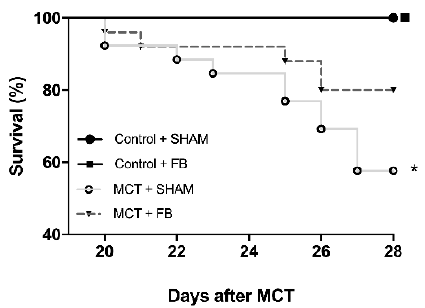
Figure 7. Effect of xanthohumol-fortified beer (FB) on animal survival. The absence of survival curve in Control + SHAM means that all the animals survived until the end of the protocol; the curve is superimposed with Control + FB group. Kaplan–Meier survival curves of the experimental groups are represented according to the days after monocrotaline (MCT) injection. * p < 0.05 vs. respective control groups.